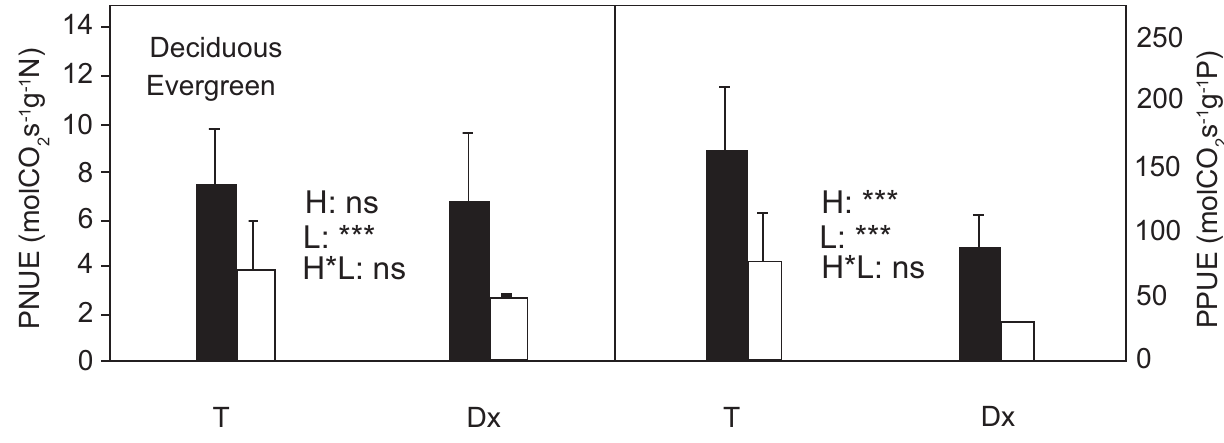
Figure 5. Photosynthetic N and P use efficiency characteristics. Effects of habitat (H), leaf phenology (L), and their interaction (H × L), on photosynthetic N and P use efficiency (PNUE and PPUE, respectively) (mean ± SD, n = 3–5) of the tree species in two habitats. See Figure 1 for other